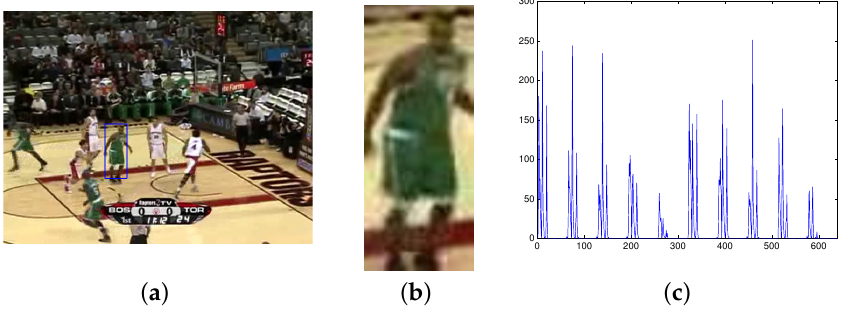
Figure 5. The representation model of the target by the proposed algorithm. ( a ) 1st frame; ( b ) target model region; ( c ) the histogram of CT